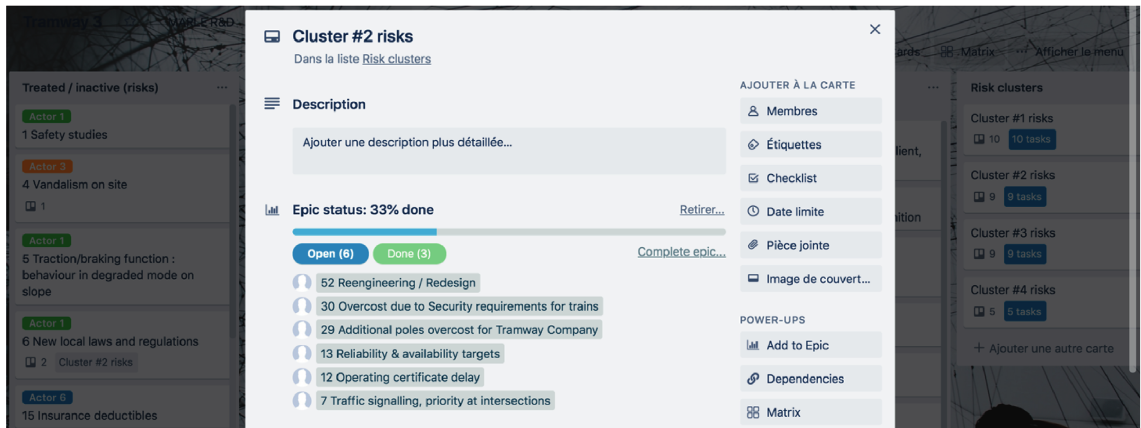
Figure 10: Follow-up for cluster 2 of the 9 risks included in this